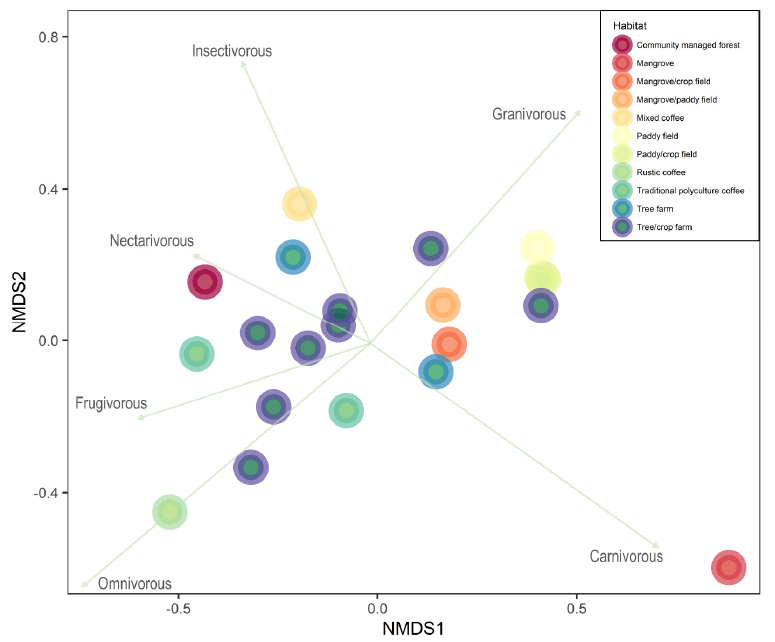
Figure 5. Non-metric multidimensional scaling representing the composition of foraging guilds at the 21 sites. Different colours indicate the main habitat in the study sites (or two main habitats if they were equally